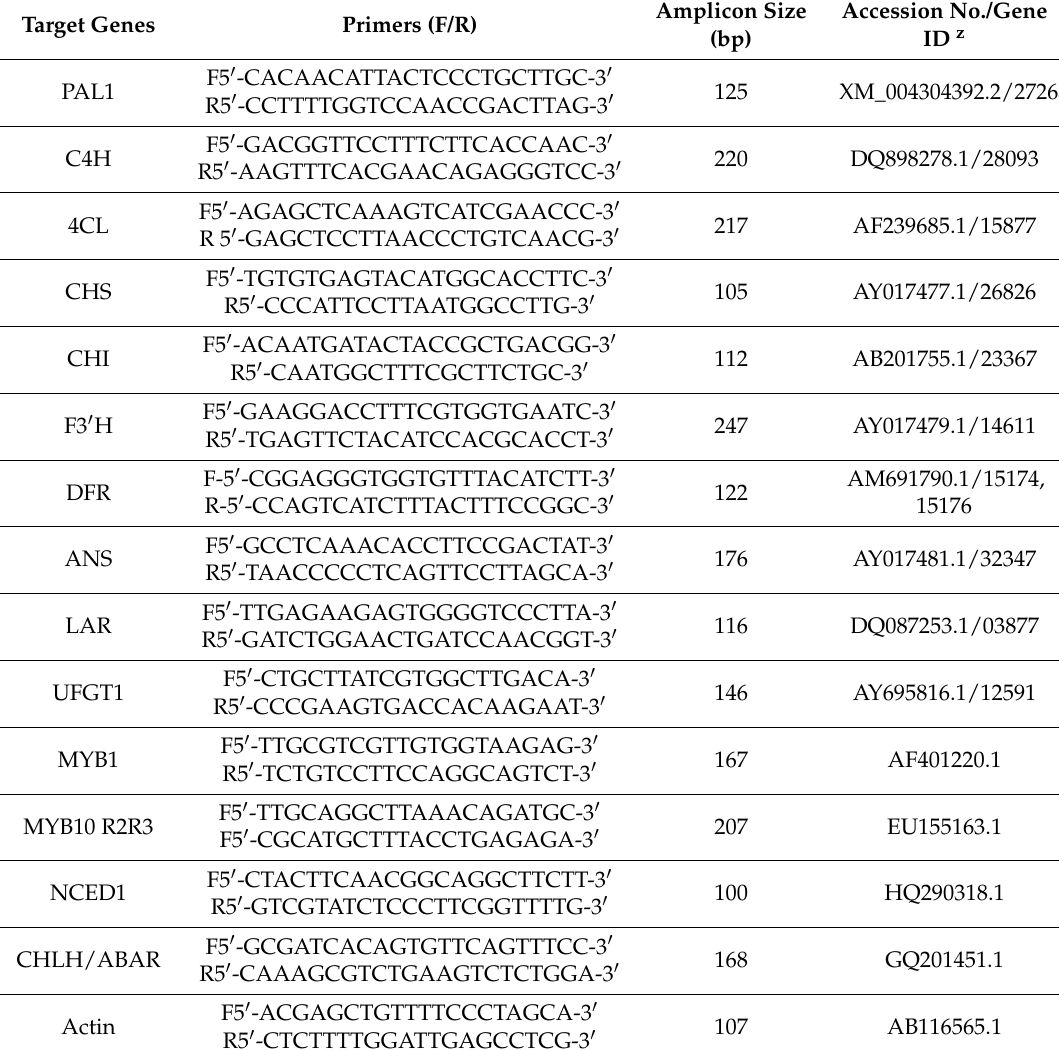
Table 1. Primer sequences of the phenylpropanoid and flavonoid genes and the housekeeping gene (actin) used for qRT-PCR. The primers were designed based on the gene transcripts with Gene IDs from a public